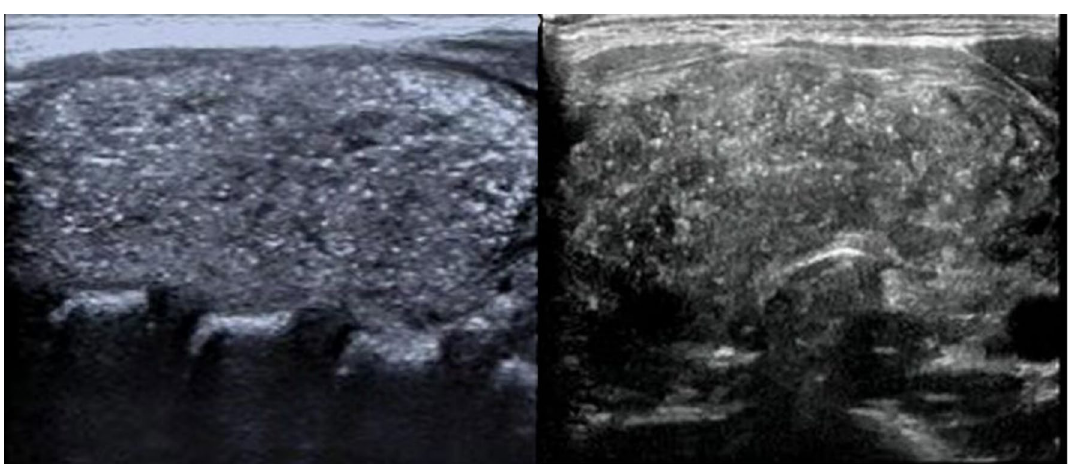
Figure 2. Ultrasonographic images of thyroid in pediatric PTC patients, showing diffuse microcalcification.